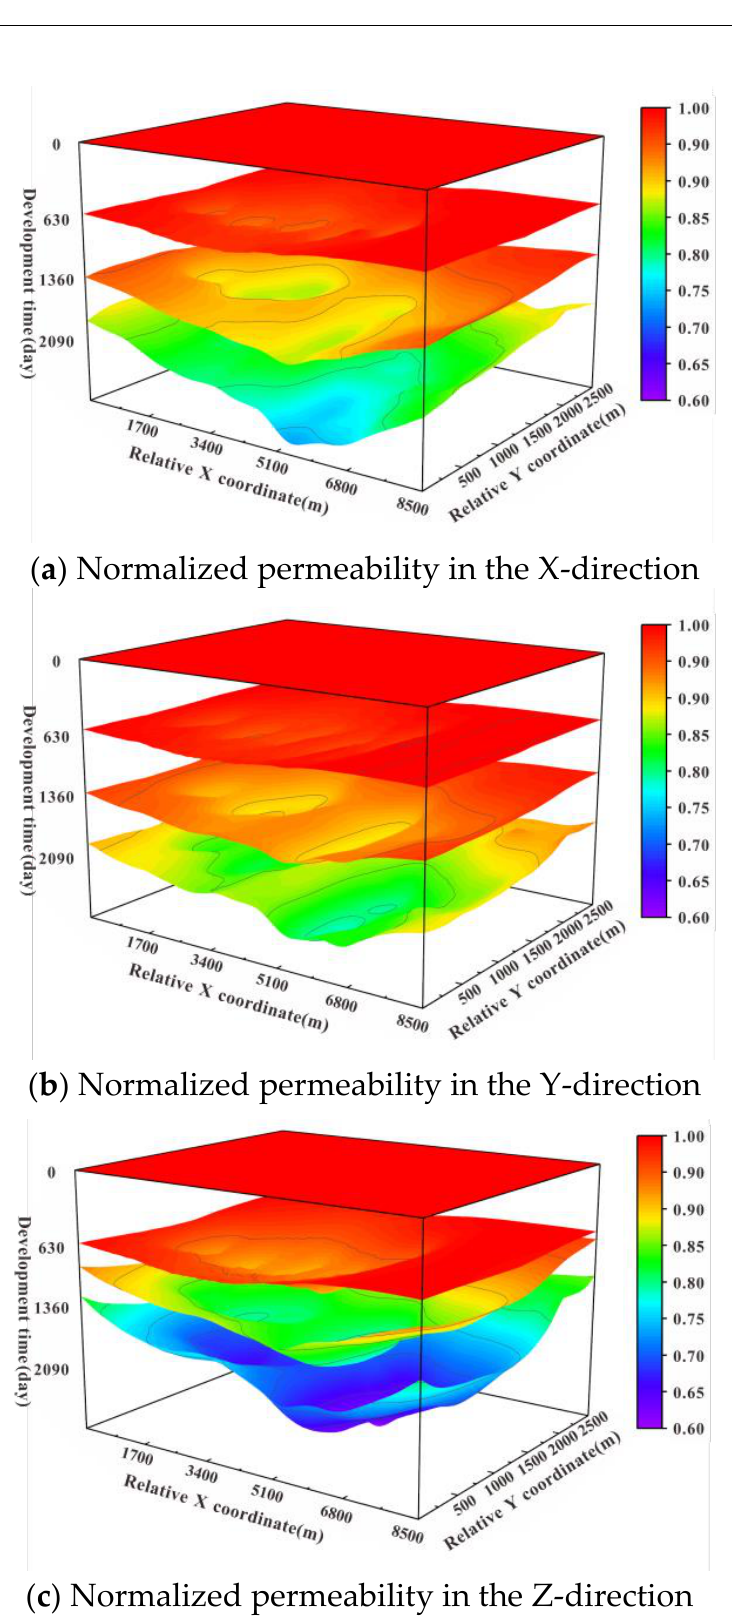
Figure 18. Normalized permeability contours of fracture systems.